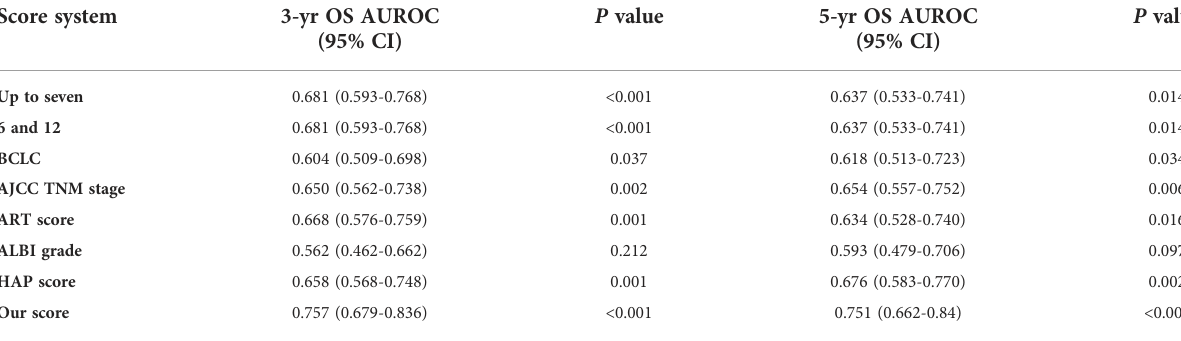
TABLE 5 The discriminative ability for overall survival of different